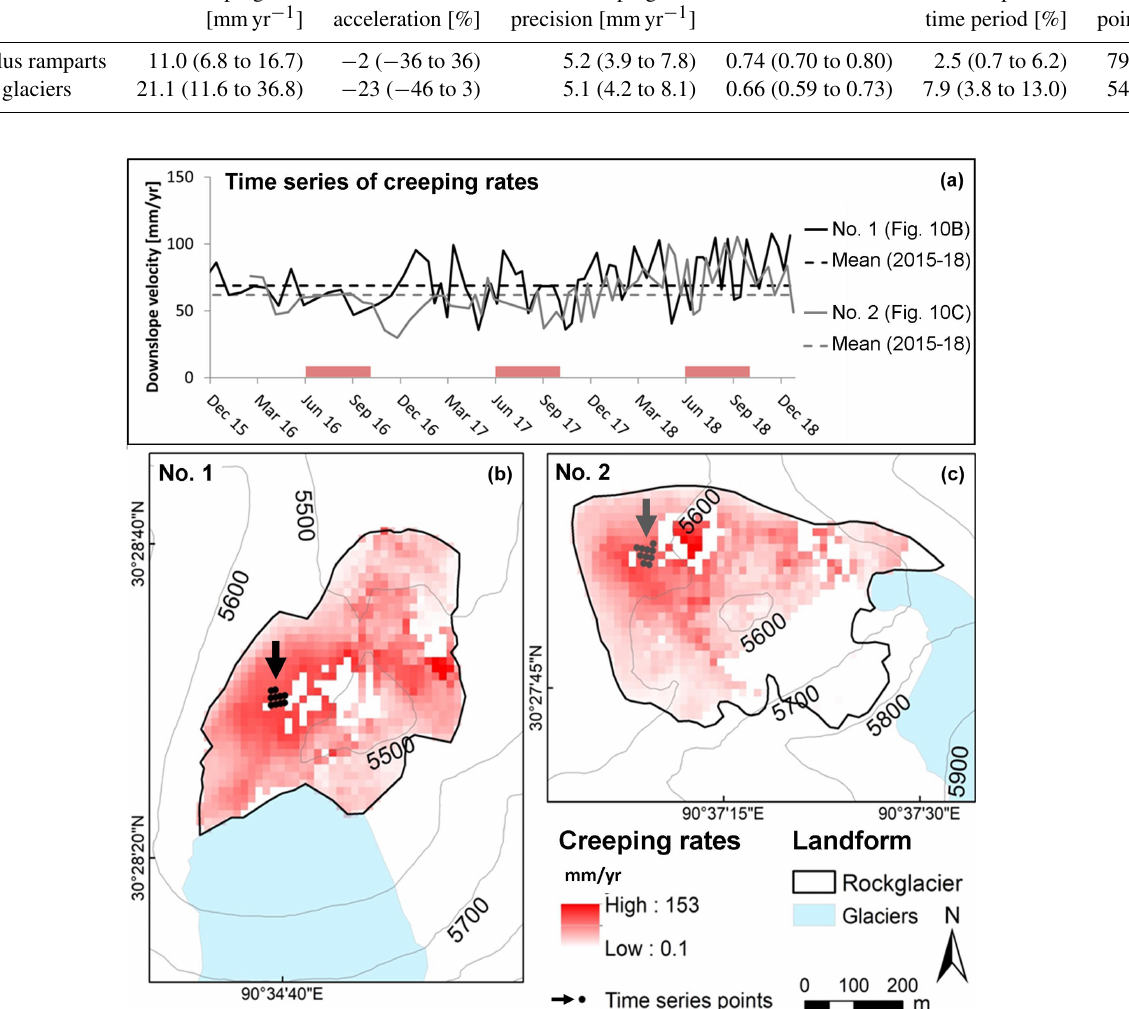
Figure 10. (a) Summer months with air temperatures > 0 ◦ C (according to Zhang et al., 2013) are shown in red. Time series represent the moving average of the 10 nearest values in time based on the median of time series points, located in (b) (black dots) and (c) (grey dots). The black time series (rock glacier no. 1 in b ) is based on ascending data and the grey time series (rock glacier no. 2 in c ) on descending